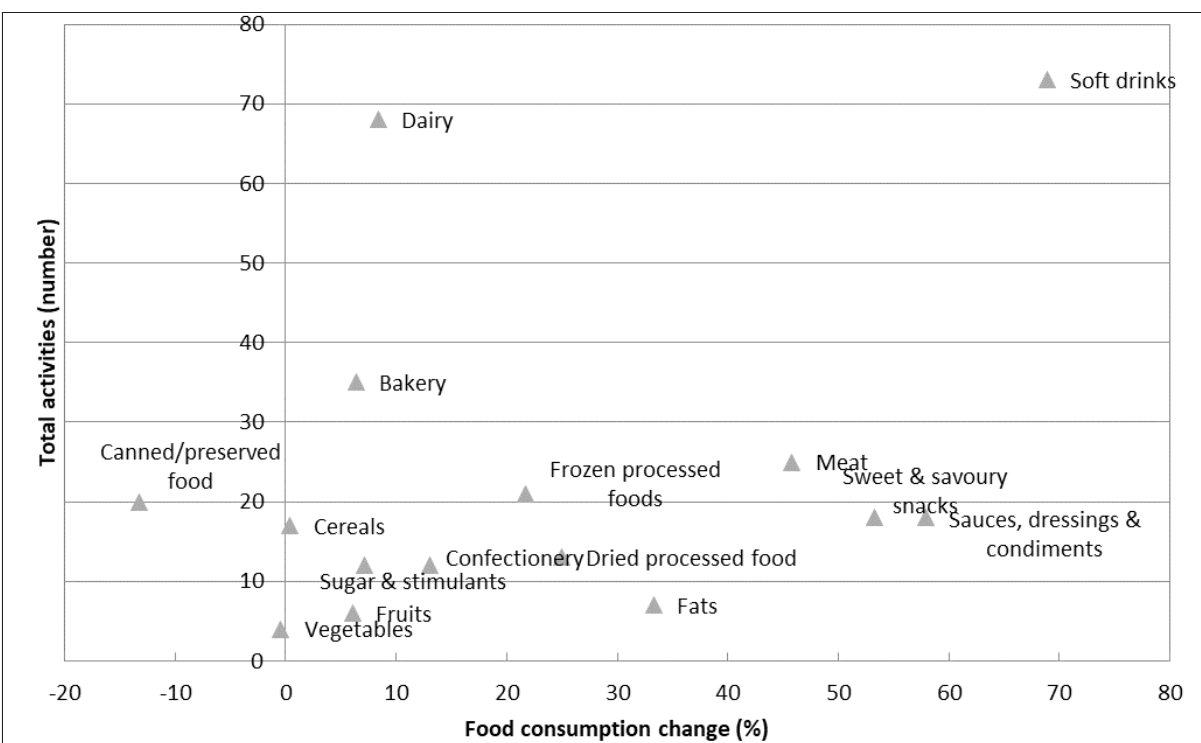
Figure 9: Number of activities by sector combined for both Food & Beverage Reporter and South African Food Review data since 1986 compared with food consumption shifts from 1994/1999 to